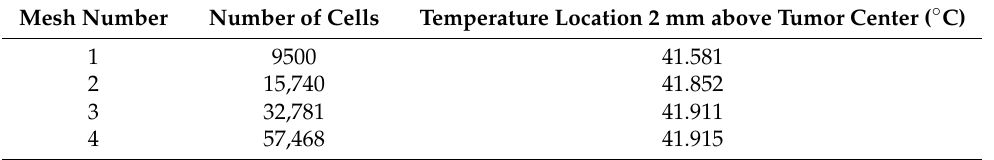
Table 3. Mesh sensitivity analysis results.